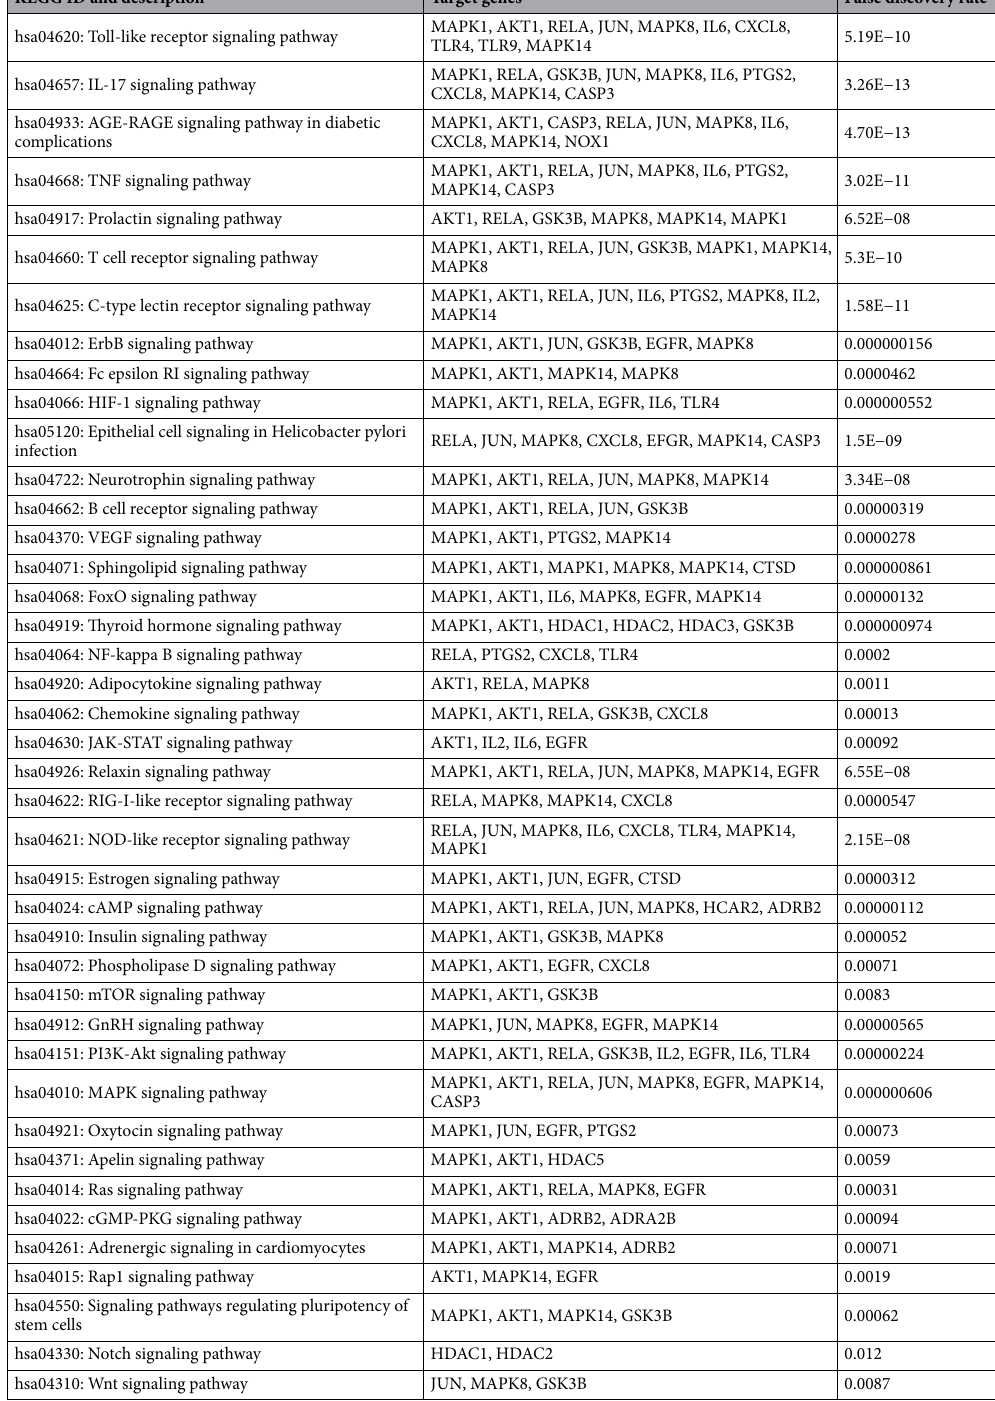
Table 2. The targets of 41 signaling pathways related to NAFLD. HDAC5, histone deacetylase 5; ADRA2B, alpha-2B adrenergic receptor; HCAR2, hydroxycarboxylic acid receptor 2; ADRB2, adrenoceptor